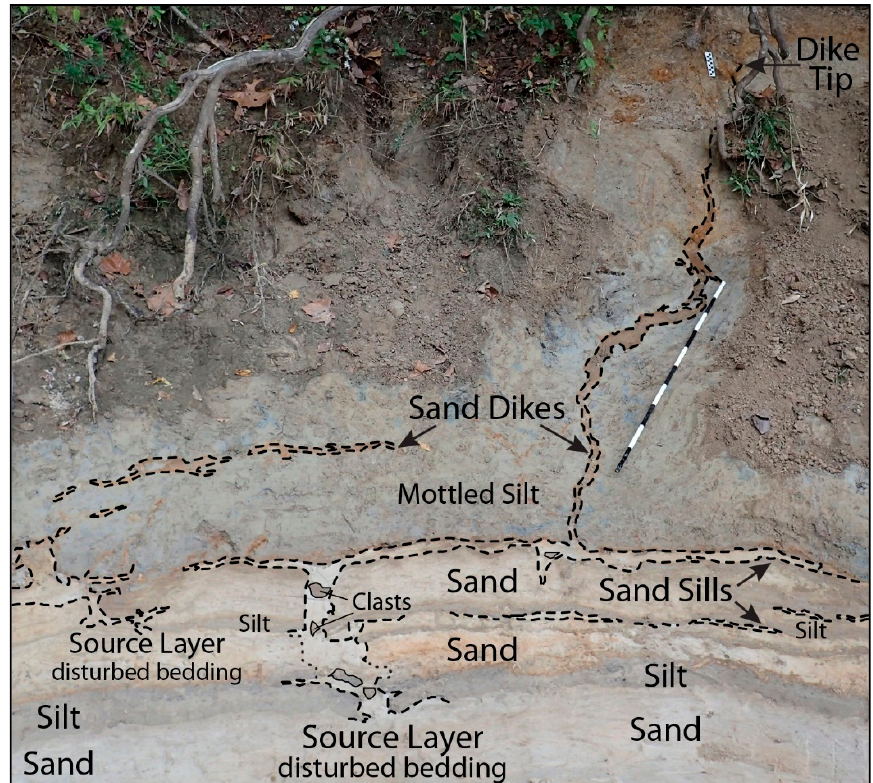
Figure 6. Annotated photograph of liquefaction features exposed in a river cutbank in northwestern Mississippi southeast of the New Madrid seismic zone in the central United States (US) [117]. Source layers that liquefied occur at the base of the cutbank, sand dikes crosscut overlying interbedded silt and sand layers and mottled silt, and sills intrude along the basal contacts of silt layers. The black and white intervals on the meter stick represent 10 cm. Photograph by M. Tuttle.